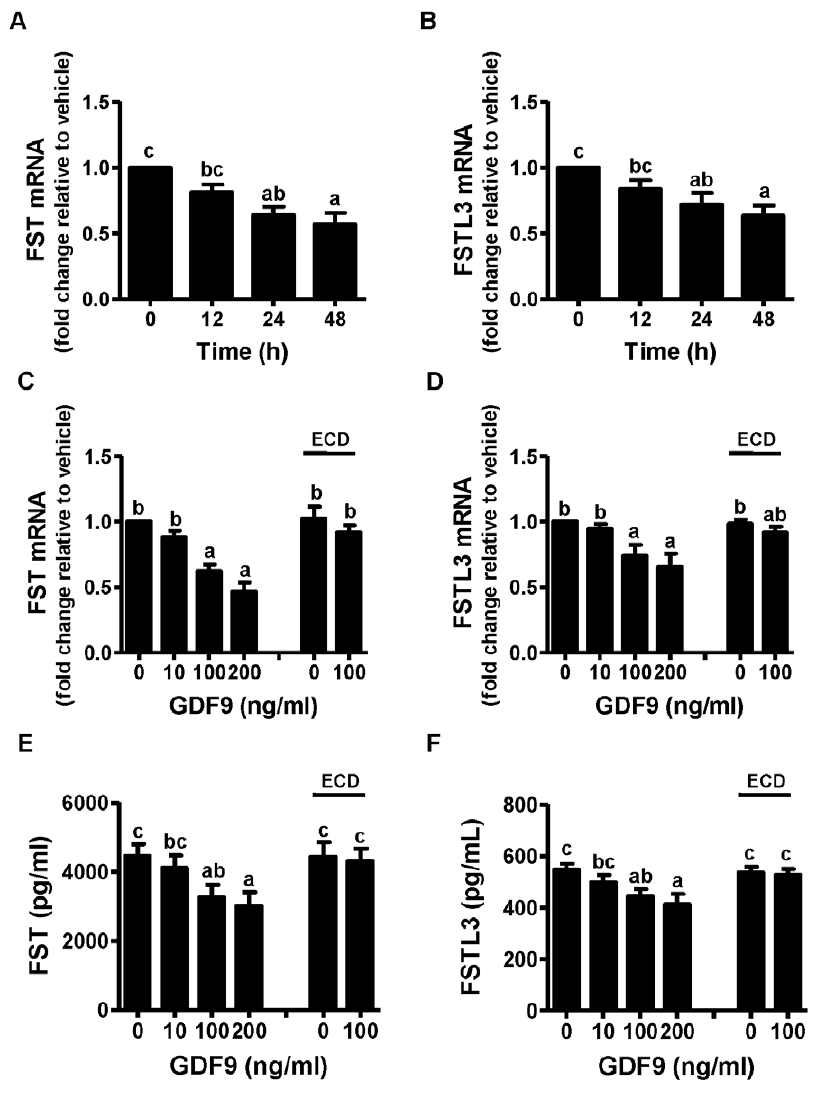
Figure 1. Effects of GDF9 on FST and FSTL3 mRNA and protein levels. After 48 h preculture, the culture media were replaced with low- serum media (0.5% FBS); hGL cells were then treated with 100 ng/ml GDF9 for 12 h (‘‘Time 12 h’’), 24 h (‘‘Time 24 h’’) and 48 h (‘‘Time 48 h’’) in time- dependent experiments (A and B), or with different doses of GDF9 for 24 h in dose-dependent experiments (C, D, E and F). In neutralization experiments to render GDF9 inactive, 2 m g/ml of BMPR2 ECD (‘‘ECD’’) and 100 ng/ml of GDF9 were preincubated in low-serum media for 30 min before adding to cultured hGL cells. FST and FSTL3 mRNA levels (A, B, C and D) in hGL cells and protein concentrations (E and F) in culture media were assessed by real-time PCR and ELISA, respectively. Results were the means 6 SEM from at least four sets of experiments (each from a separate patient), and in each set, measurements were made in triplicate for real-time PCR or duplicate for ELISA. Means without a common letter are significantly different ( P ,